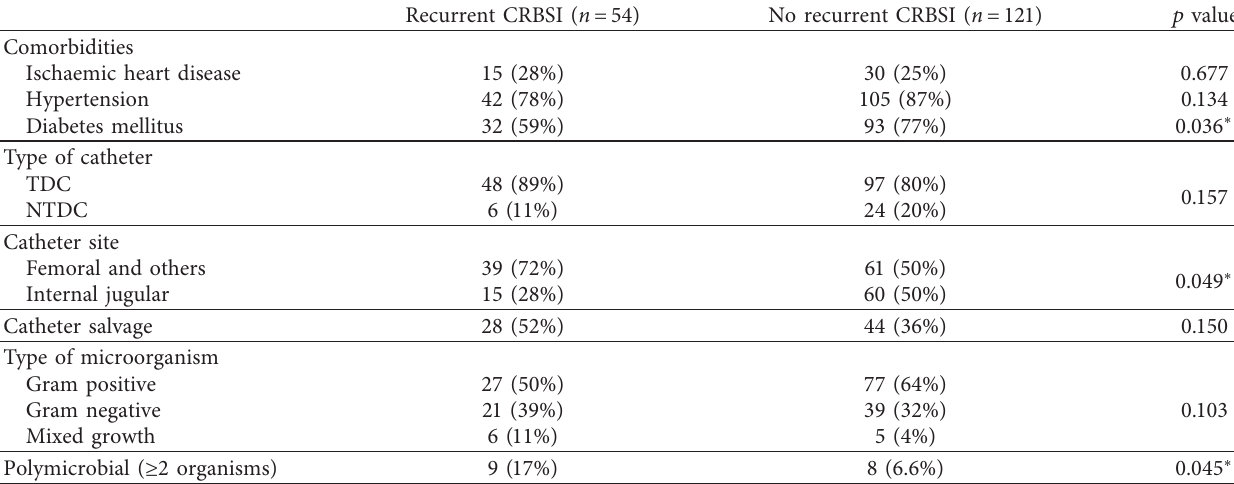
Table 5: Factors associated with recurrent of CRBSI after an